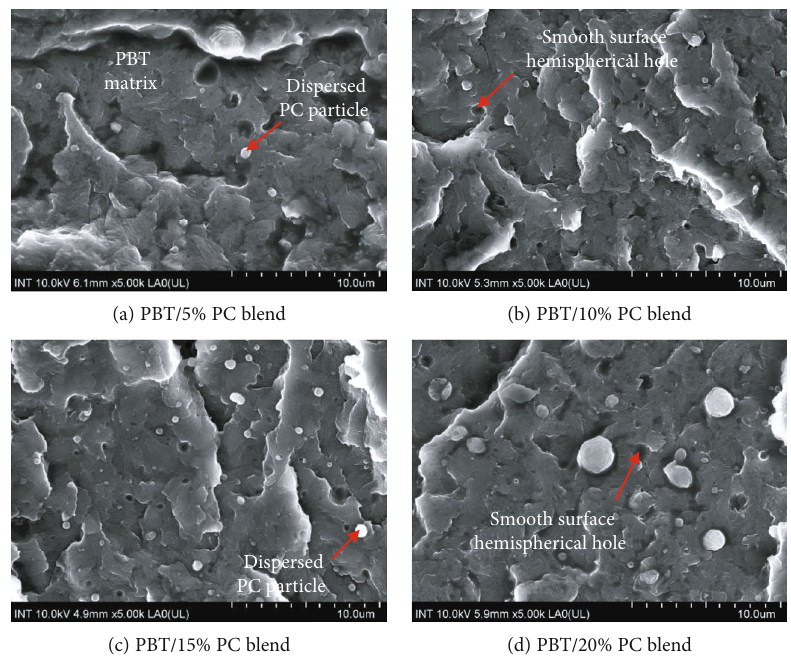
Figure 6: FESEM of fracture surface of PBT/PC blends sample at high magni fi